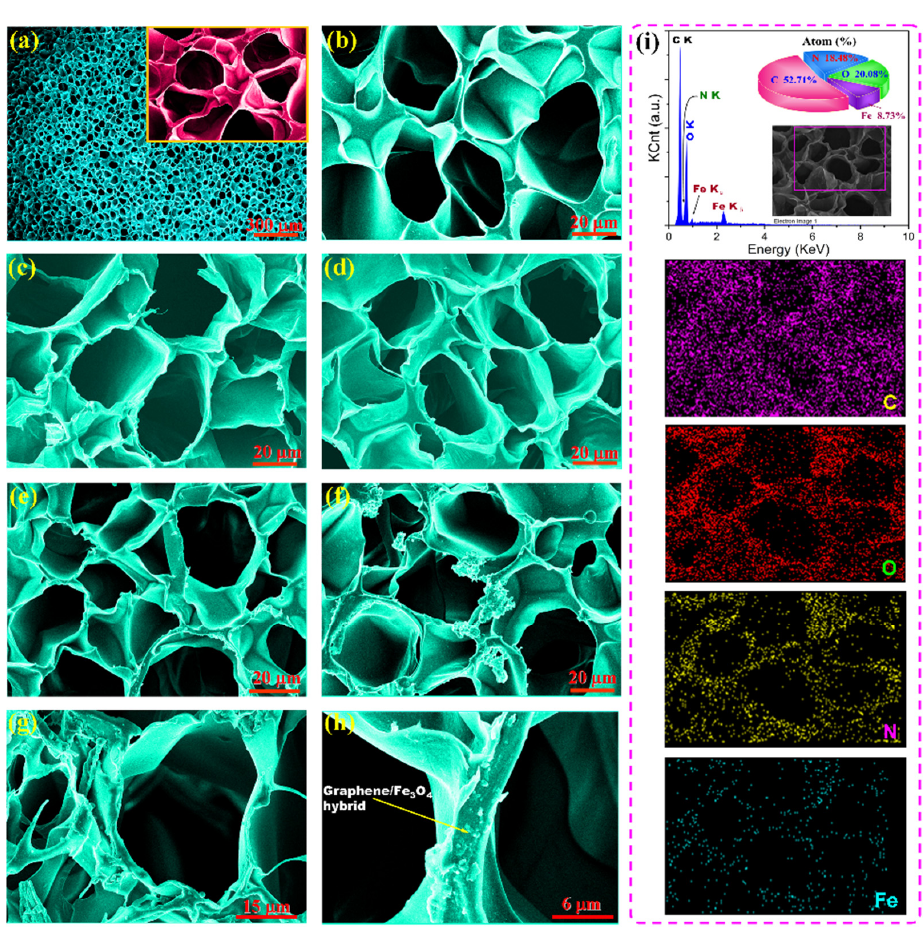
Figure 4. SEM images of ( a ) pure PI aerogel film and the PI/graphene/Fe 3 O 4 hybrid aerogel films with a graphene content of 5 wt% and different Fe 3 O 4 contents of ( b ) 0, ( c ) 2, ( d ) 4, ( e ) 6, and ( f – h ) 8 wt%. ( i ) EDX spectrum and elemental mapping images of the PI/graphene/Fe 3 O 4 hybrid aerogel film. The elemental distribution and chemical structure of the PI/graphene/Fe 3 O 4 hybrid aerogel films were characterized with EDX, FTIR, XRD, and XPS using the hybrid aerogel film containing 5 wt% of graphene nanosheets and 6 wt% of Fe 3 O 4 nanoparticles as